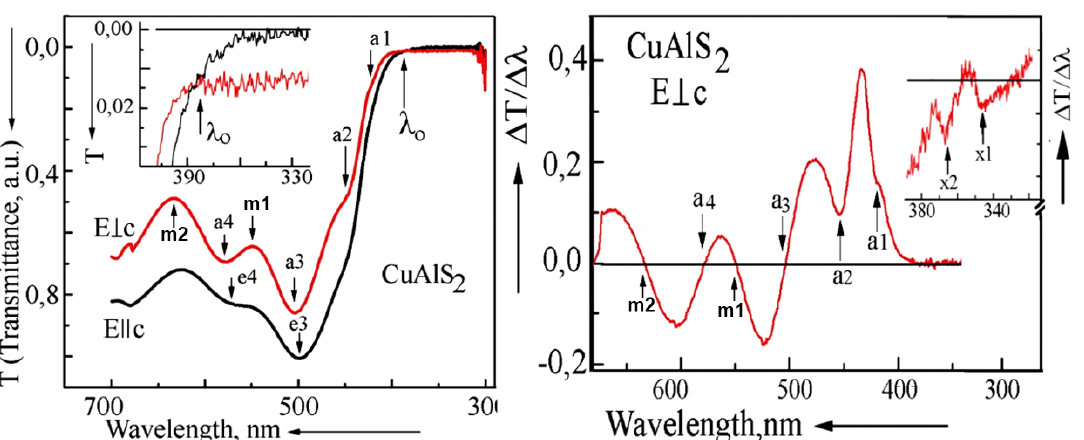
Figure 3. Transmission spectra anisotropy (left) and wavelength modulated transmission spectra (right) of CuAlS single crystals with thickness of 223 2